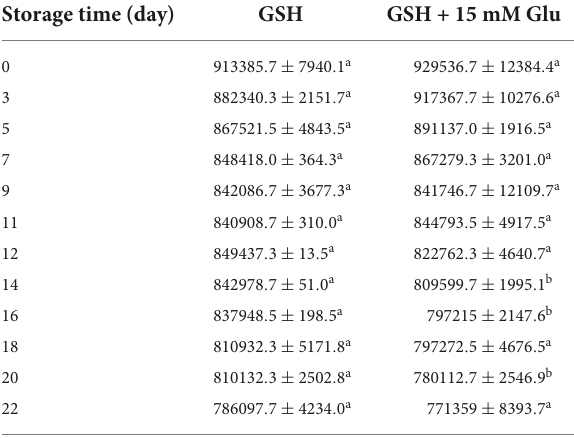
TABLE 1 The change of thiols on GSH in the absence and presence of 15 mM